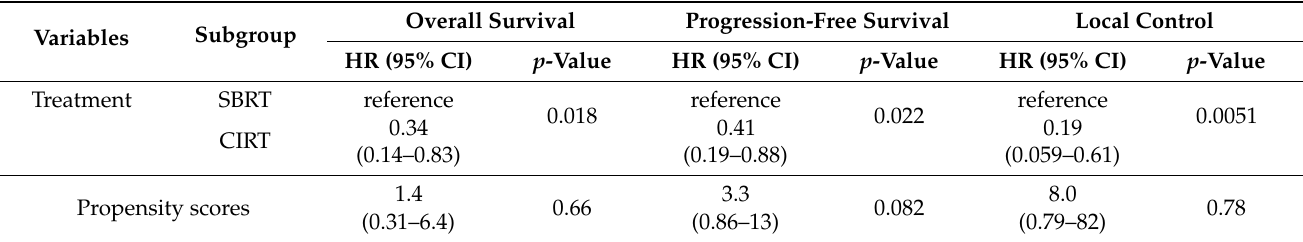
Table 4. Cox regression analysis using the propensity scores as covariates ( n = 89). Variables Subgroup